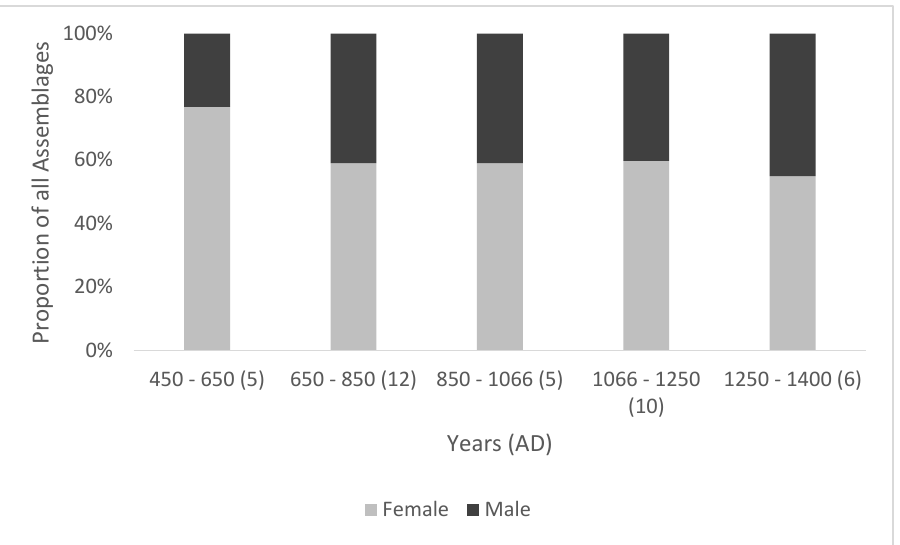
Figure 4. Relative proportion of male and female cattle pelves recorded from the targeted sites. ( n ) = number of assemblages.